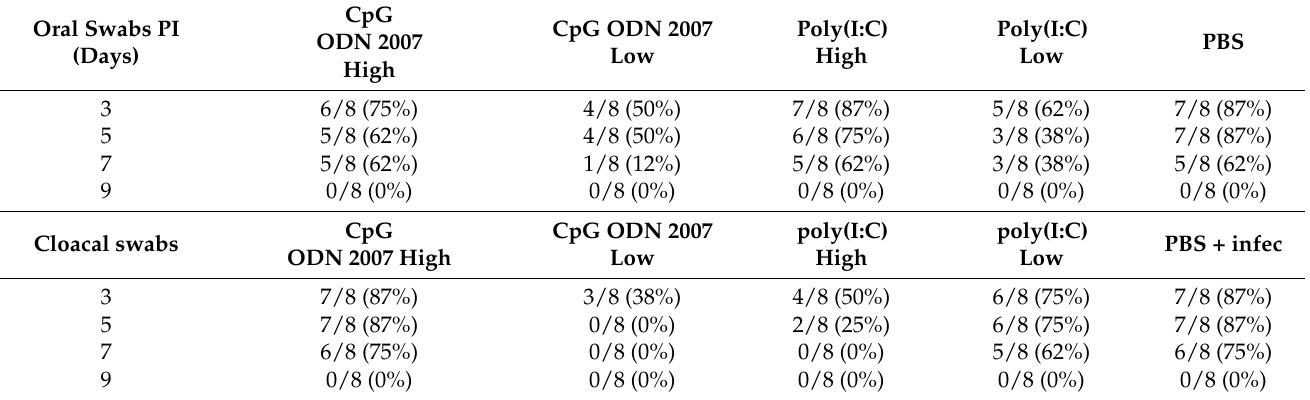
Table 3. Rate of infection in recipient chickens of different treatment groups ( n =